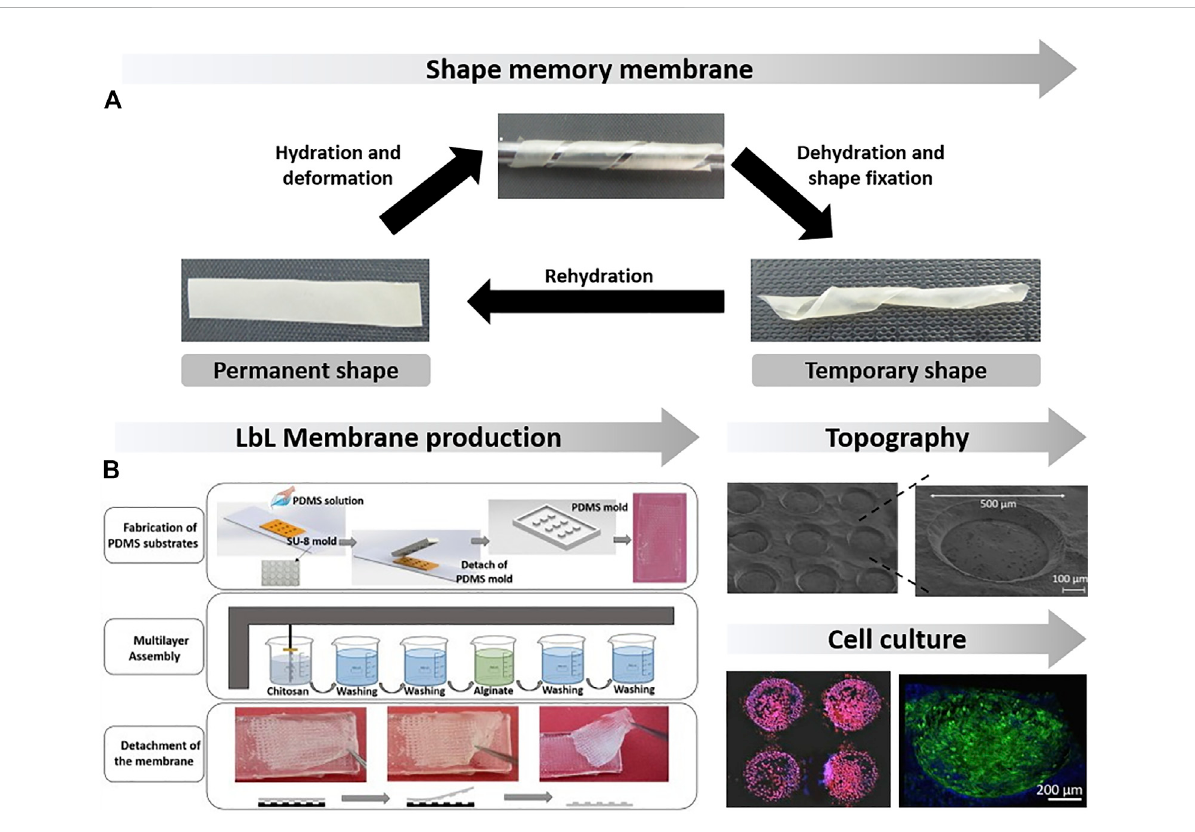
FIGURE 4 (A) Shapememory behavior of (CHT/ALG)100 freestanding multilayered membranes induced by hydration. Reproduced from ref (Borges et al., 2015). with permission from John Wiley & Sons, Copyright 2015 WILEY-VCH Verlag GmbH & Co. KGaA, Weinheim; (B) Freestanding multilayered membranes patterned with micro-wells, wherein cells tended to colonize preferentially. Adapted from (Martins et al., 2017) with permission from Elsevier, Copyright